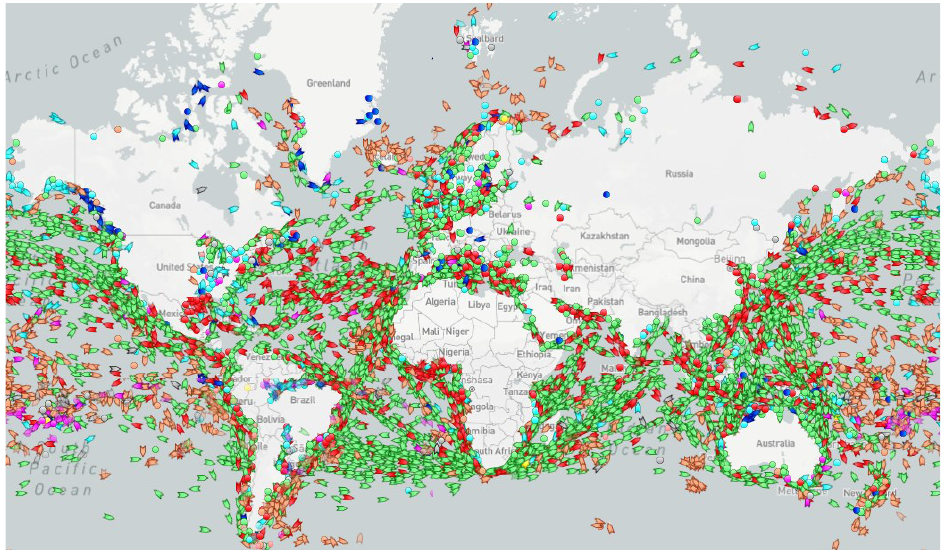
Figure 8. Maritime traffic over the globe, where different colors represent different types of ships (image from https://www.marinetraffic.com/) (accessed on 9 May 2022). Ocalan and Alkan (2012, 2013) [10,11] attempted to investigate the limits of the PPP technique in the context of the “GPS on boat” method, comparing their results obtained using PPP with the corresponding ones using the D-GPS/GNSS method. It was the first time that both methods had been used comparatively. It was also the first time that the “ GPS on boat ” method had been applied in a closed bay. In fact, they took measurements over a two-hour period in Halic (Golden Horn) of Istanbul (Turkey) using an Ashtech Z- Xtreme GNSS receiver (Mumbai, India) mounted on a small boat (Figure 9). It was found that the web service solutions of the PPP method were consistent with the results of the kinematic differential method. Thus, it was proved at a certain level of certainty that PPP can be used successf ully in the context of the “GPS on boat” method. Figure 9. Photos from the study area and vessel’s route [11].